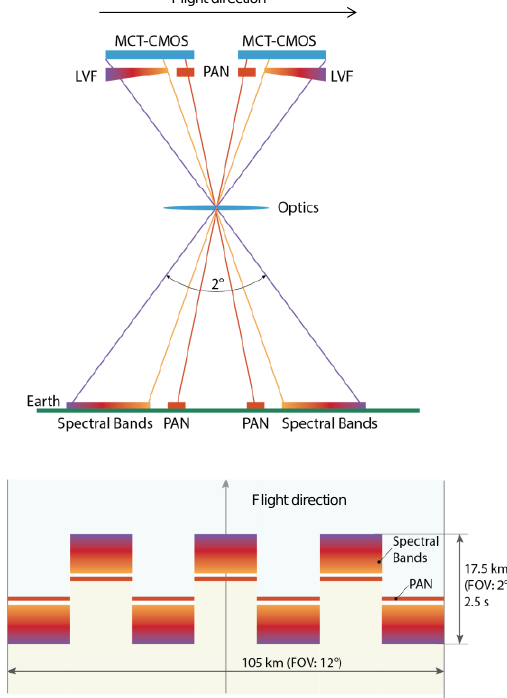
Figure 7. Instrument observation principle.